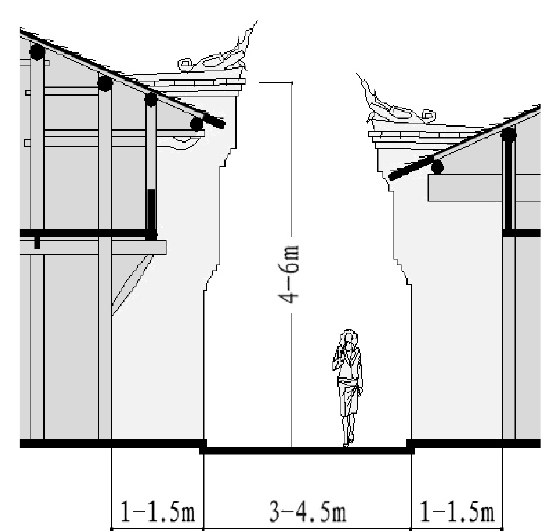
Figure 28. Street section.